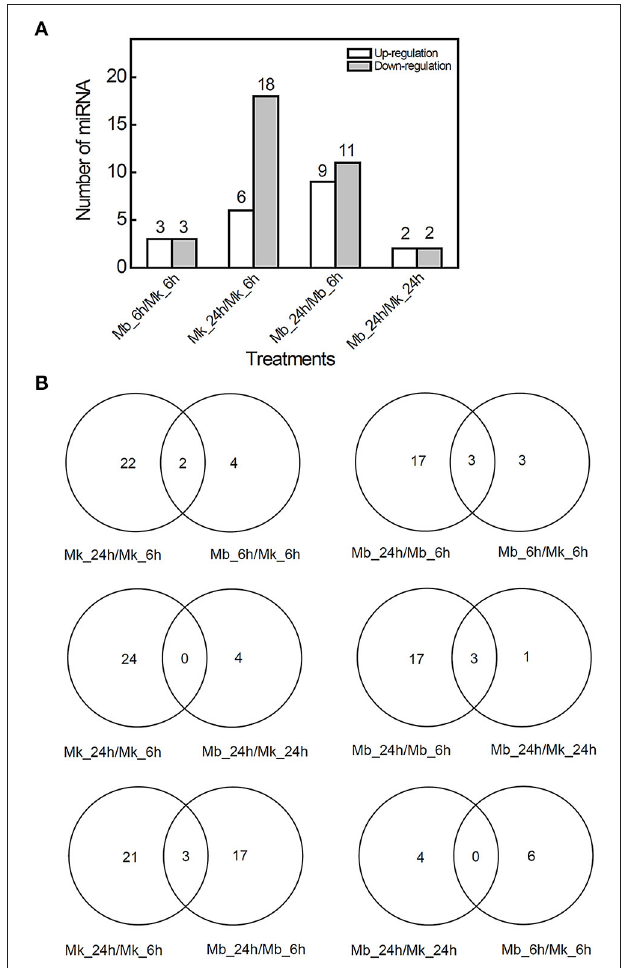
FIGURE 4 | Analysis of differential known microRNA expression in M. brunnea -infected poplar leaves. (A) The upregulated and downregulated (|log 2 foldchange| ≥ 1 and P < 0.05) amount and (B) the Venn diagram of differentially expressed known miRNAs